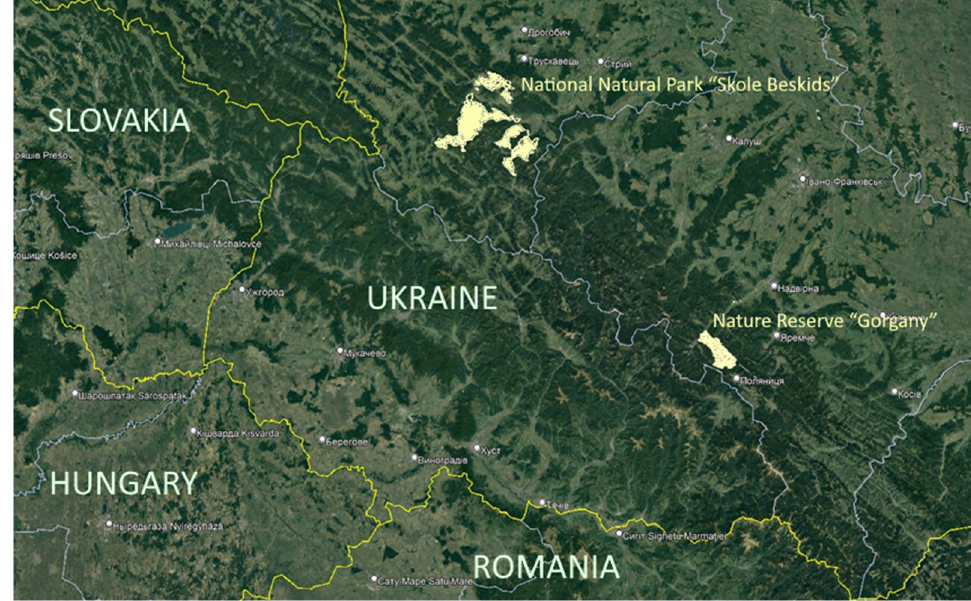
Figure 1. Location of the National Natural Park “Skole Beskids” and Nature Reserve “Gorgany” where the sample plots were established.